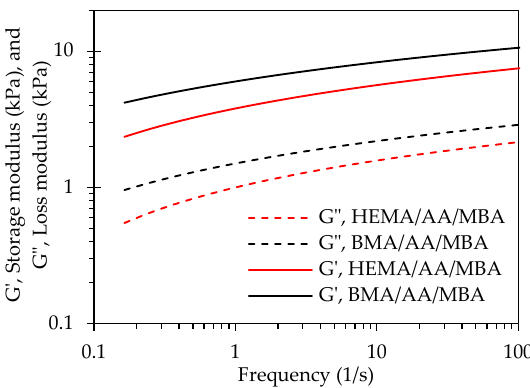
Figure 5. Storage modulus ( G ′) and loss modulus ( G ″) of the hydrogels as a function of the angular frequency.